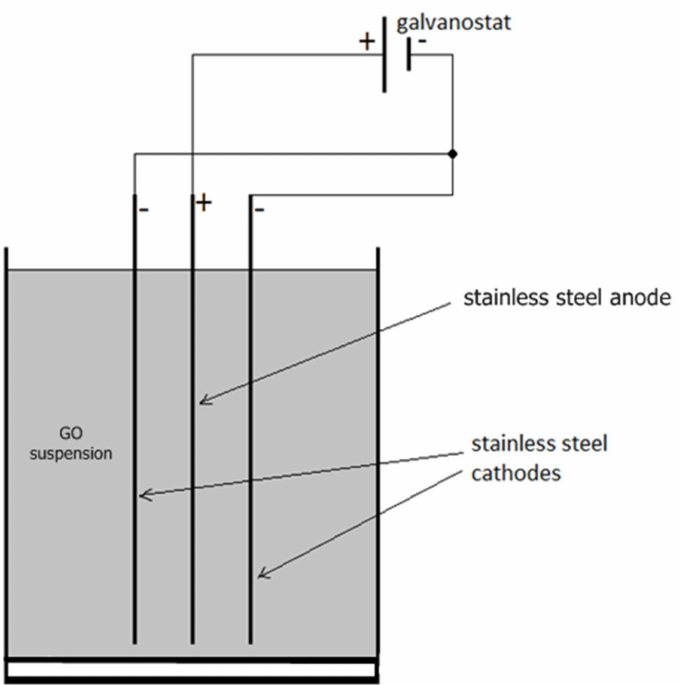
Figure 1. The scheme of typical EPD for deposition of GO on the SS substrate with one positive and two negative electrodes aligned in